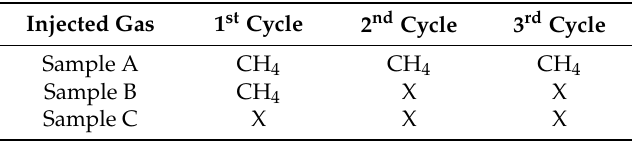
Figure 1. ( a ) Changes in Cu grains at the surface during the chemical vapor deposition (CVD) process; ( b ) CVD process conditions. At the time indicated in blue, CH 4 was injected as indicated in Table 1. Table 1. Sample treatment regarding CH 4 injection.